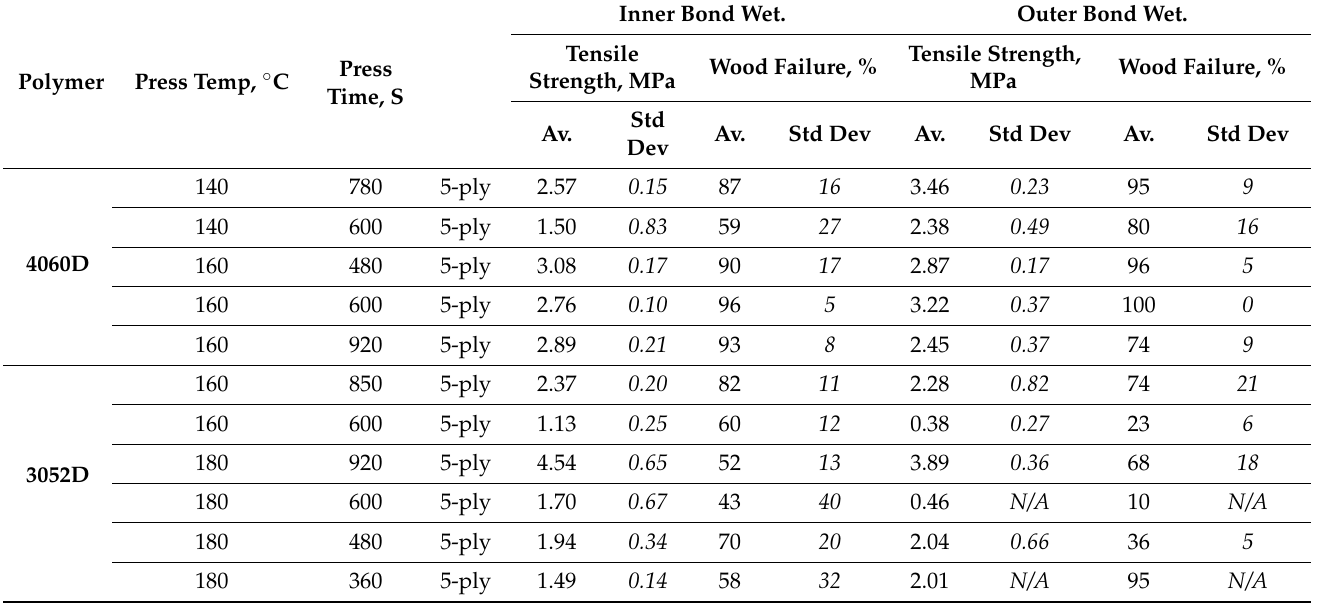
Table 4. Summary of tensile testing results after 24 h water soaking for 5- and 7-ply panels formed with radiata pine veneer and semi-crystalline and amorphous PLA grades at differing pressing temperatures and